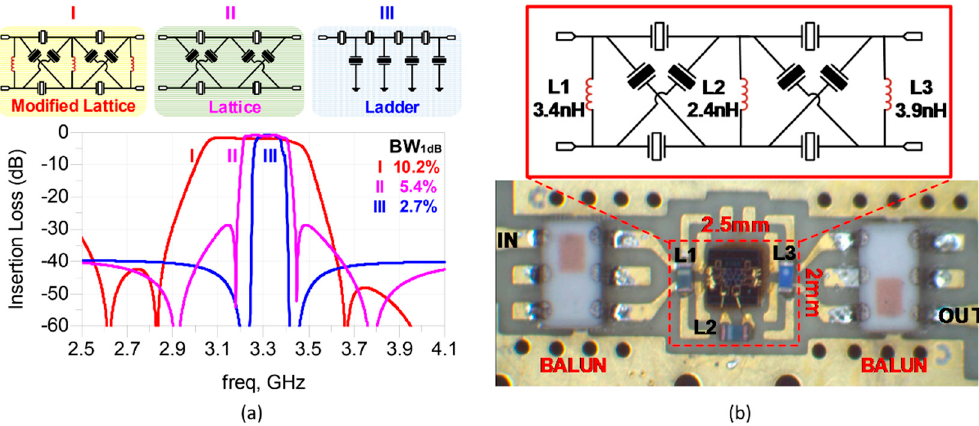
Figure 6. ( a ) Topologies of ladder type, lattice type, modified lattice with two auxiliary inductors, and their electrical responses [24]. ( b ) Board assembly of the filter with balun circuits [24]. Reproduced with permission from [24].